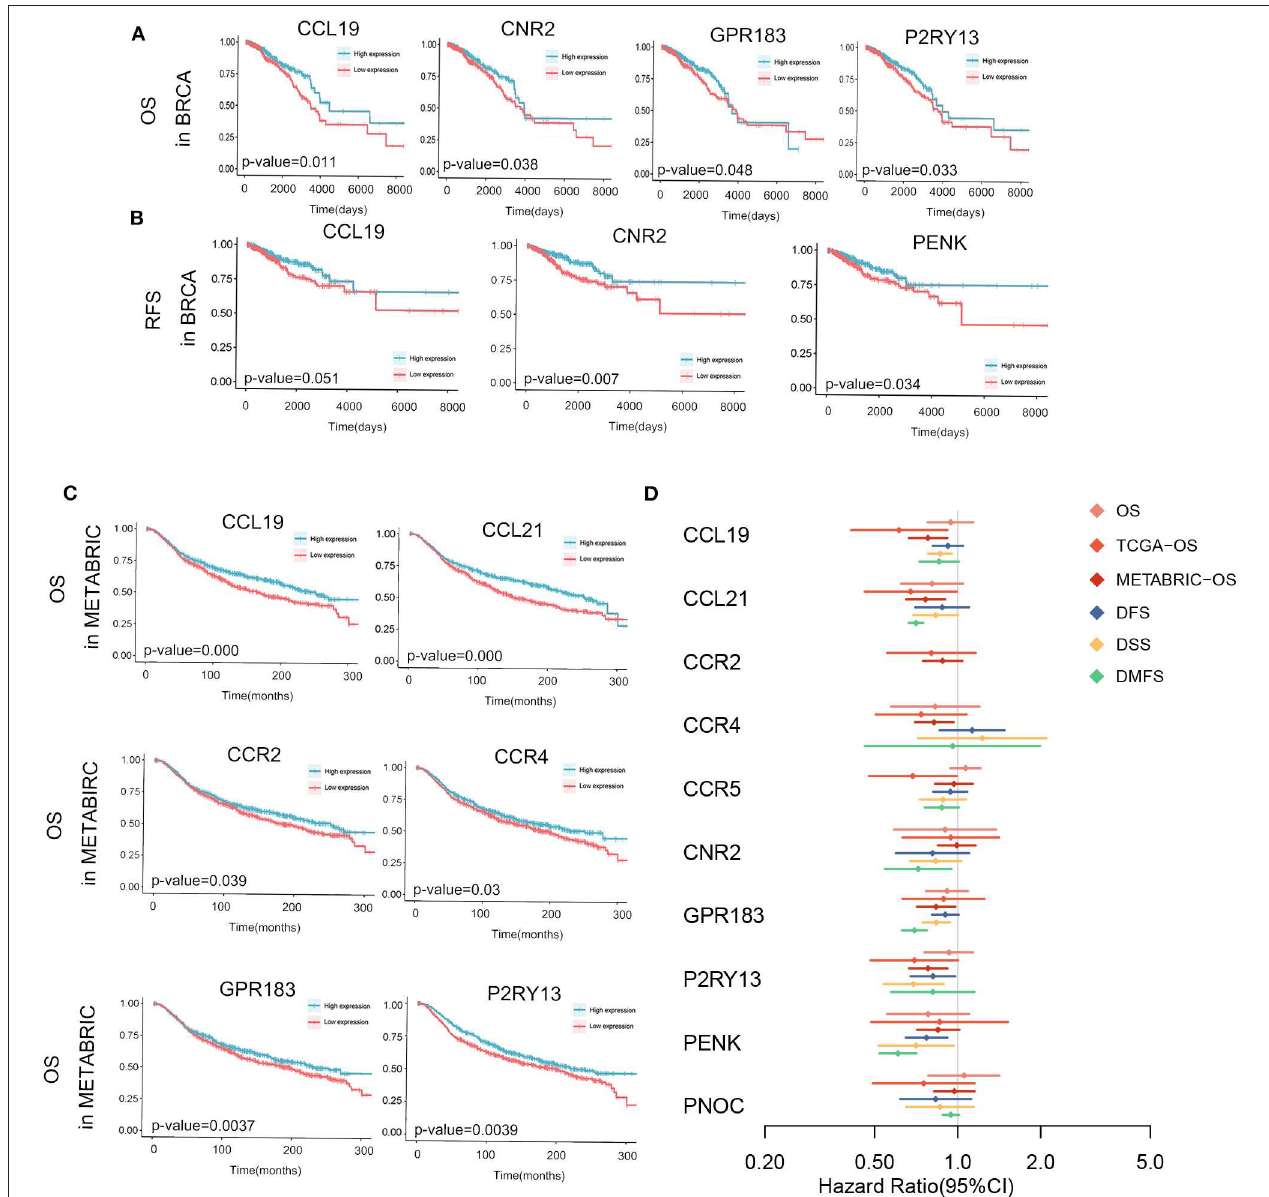
FIGURE 5 | Kaplan-Meier survival analyses and meta-analysis of survivals in multiple databases are shown. Significant OS (A) , RFS (B) in TCGA-Breast Cancer and OS of METABRIC (C) are sketched and p -values are in the plots. (D) Meta-analysis of the survival with endpoints as OS, DFS, DSS, and DMFS and cox regression of OS in TCGA and METABRIC of 10 hub genes. P < 0.05 is used as significant criteria. DFS, disease free survival; DMFS, disease metastasis free survival; DSS, disease specific survival; OS, overall